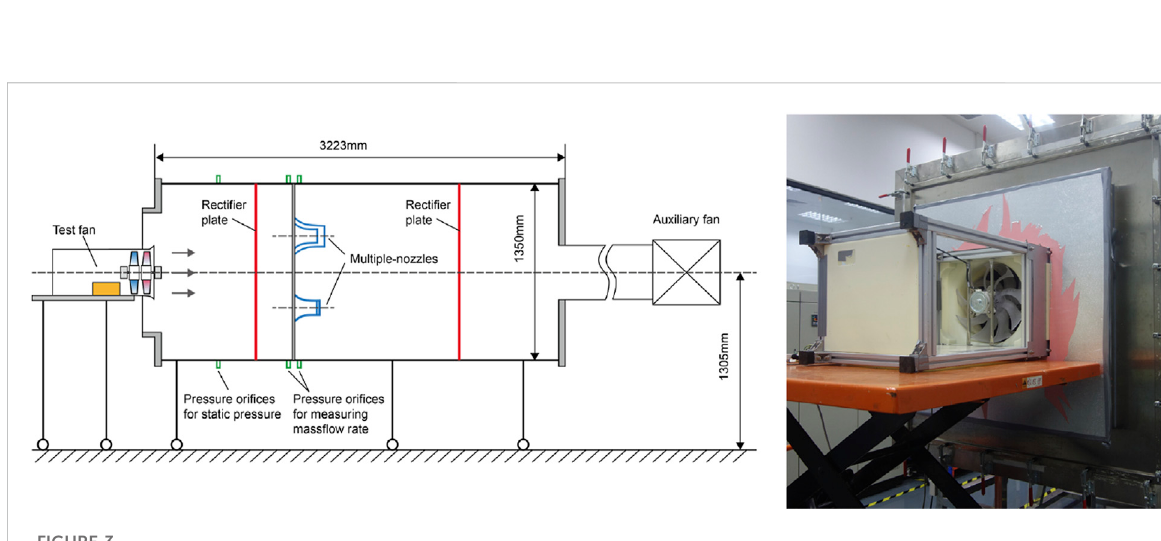
FIGURE 3 Schematic and photograph of the performance test